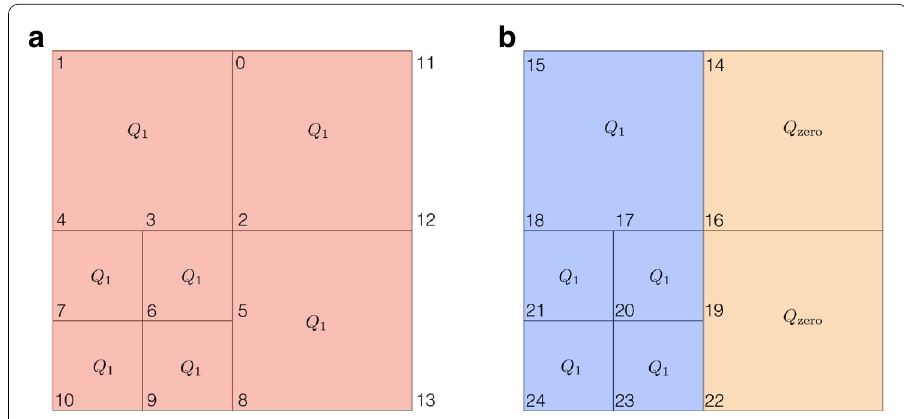
Fig. 8 Treatment of hanging nodes for the h -adaptive PUM. Q 1 denotes (bi)linear FE, whereas Q zero denotes elements on which functions in the FE space associated with the enrichment function f k ( x ) are zero and thus no DoFs need to be introduced. a First FE space (standard). b Second FE space